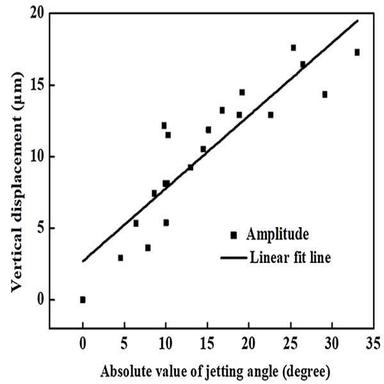
Correlation between the jetting angle and the amplitude obtained from the waves.